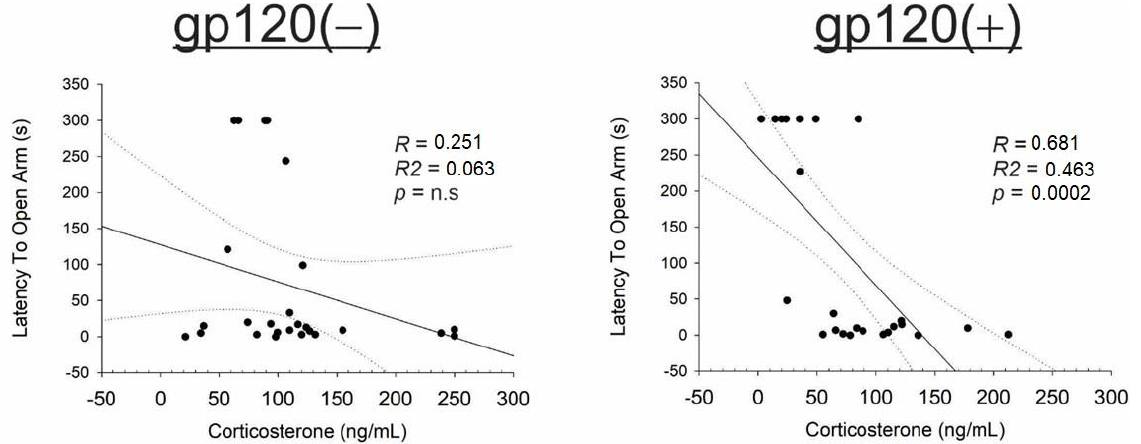
Figure 4. Simple linear regressions between circulating corticosterone among gp120( − ) and gp120(+) females and males.